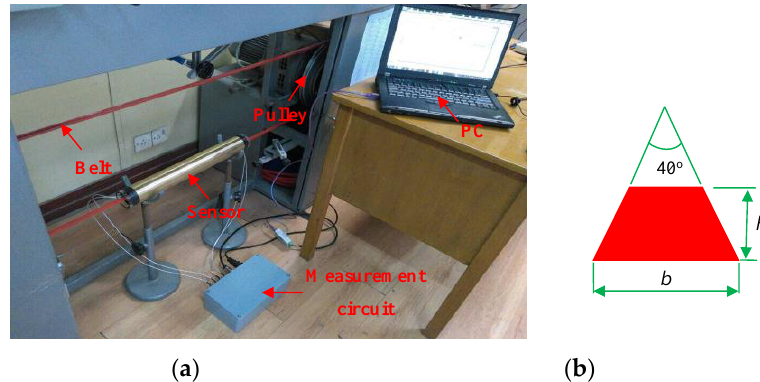
Figure 6. V-belt pulley rig: ( a ) Photograph; ( b ) Cross-section of the belt.